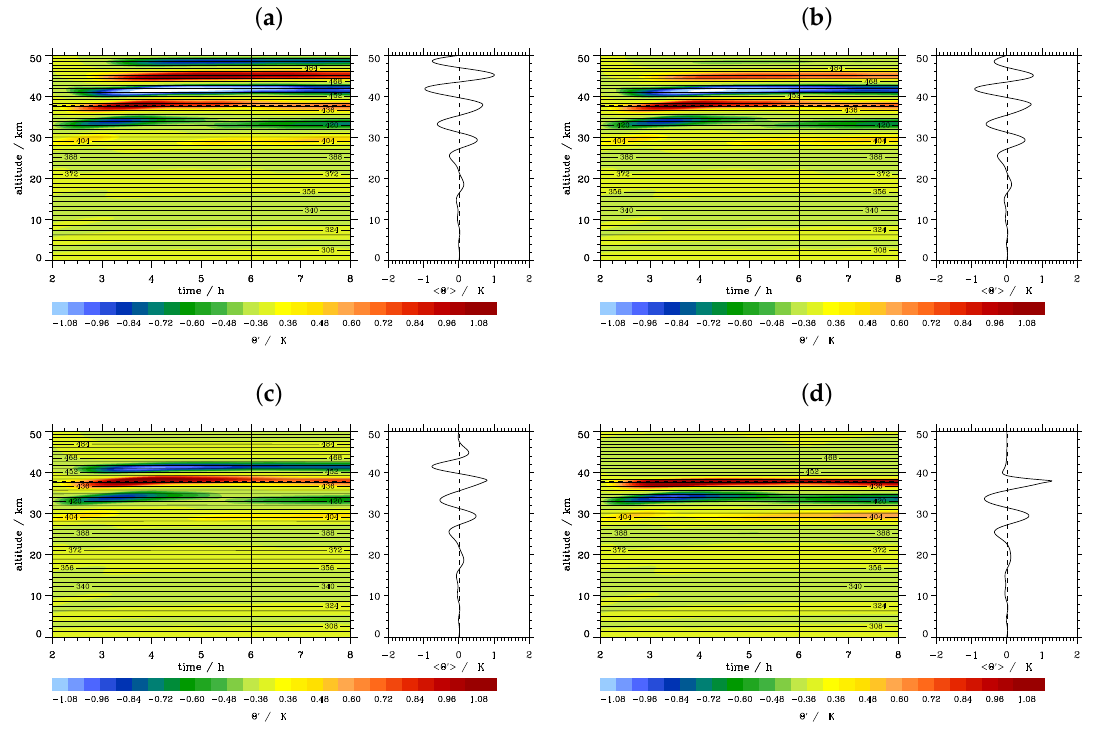
Figure 12. Vertical time series of the potential temperature perturbations Θ (cid:48) from wave regime (i) at x = 30km for ( a ) τ z = 900s, ( b ) τ z = 600s, ( c ) τ z = 270s and ( d ) τ z = 30s. The right panels depict the time-averaged Θ (cid:48) -profiles over the respective